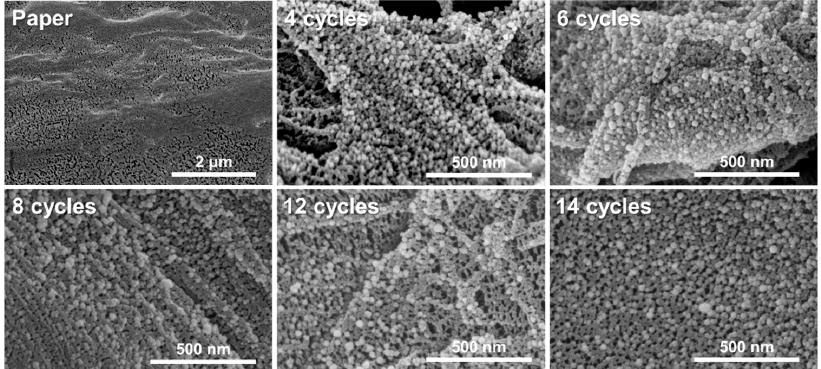
Figure 3. SEM micrographs of the resulting LbL papers after each cycle (from top right: original paper; 4, 6, 8, 12, and 14 cycles) where silver nanoparticles are evenly anchored to the surface of fibers without significant changes in particle size.